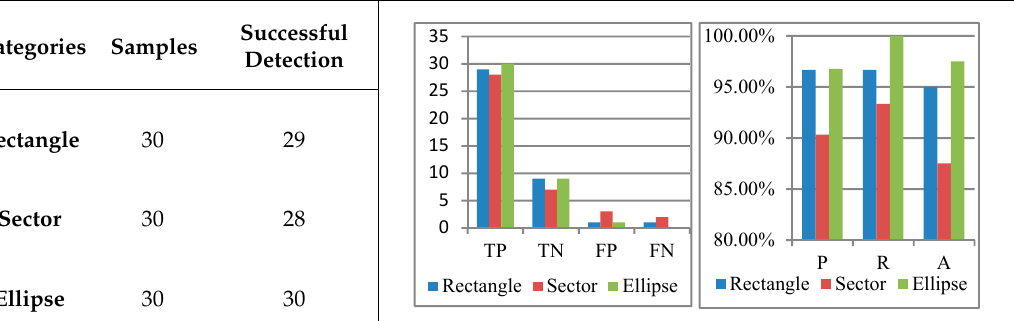
Table 2. The experimental results in our proposed method.